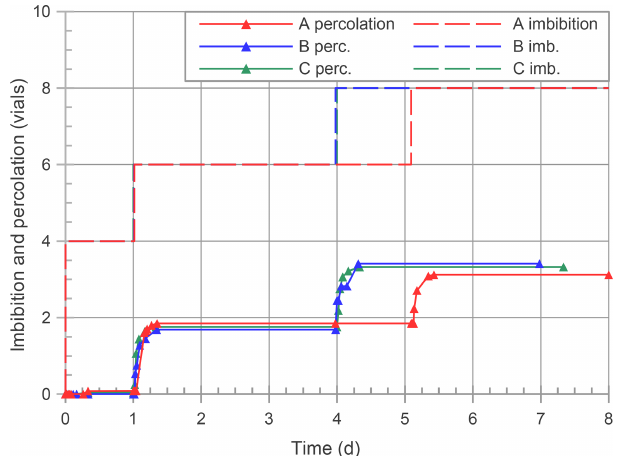
Figure 9. Imbibition and percolation volumes during the three rep- etitions of the third experiment expressed as the number of vials. The unitary volume V i of a vial was estimated to be equal to V i = 31.3, 50.5 and 41.0cm 3 for soil A, B and C, respectively, according to the procedure described in Sect. 5. A, B, C: soil identification; (cid:52) : percolation volume; dashed line: imbibition